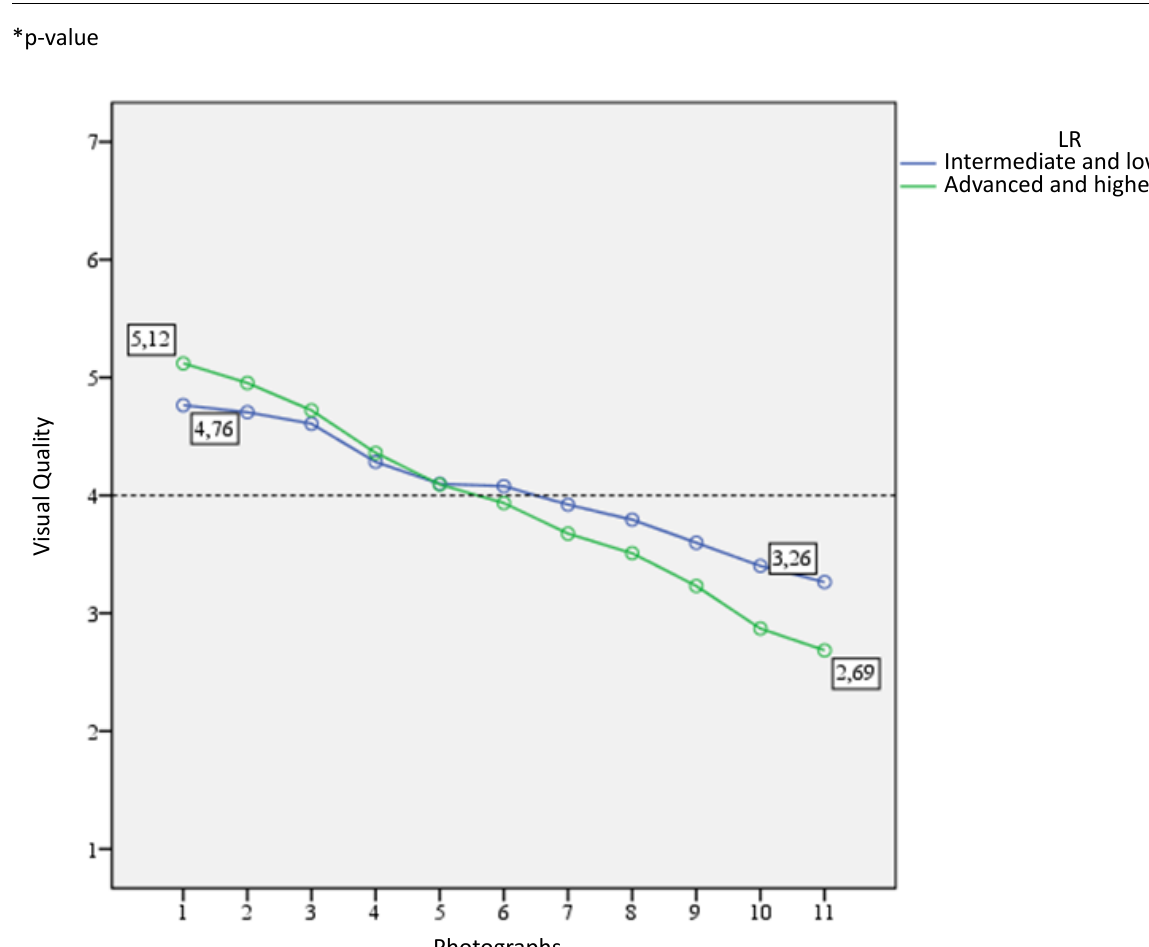
Photographs Figure 2. Curve of visual quality of participant according to climber proficiency on the basis of photographs (Chalk density effect)